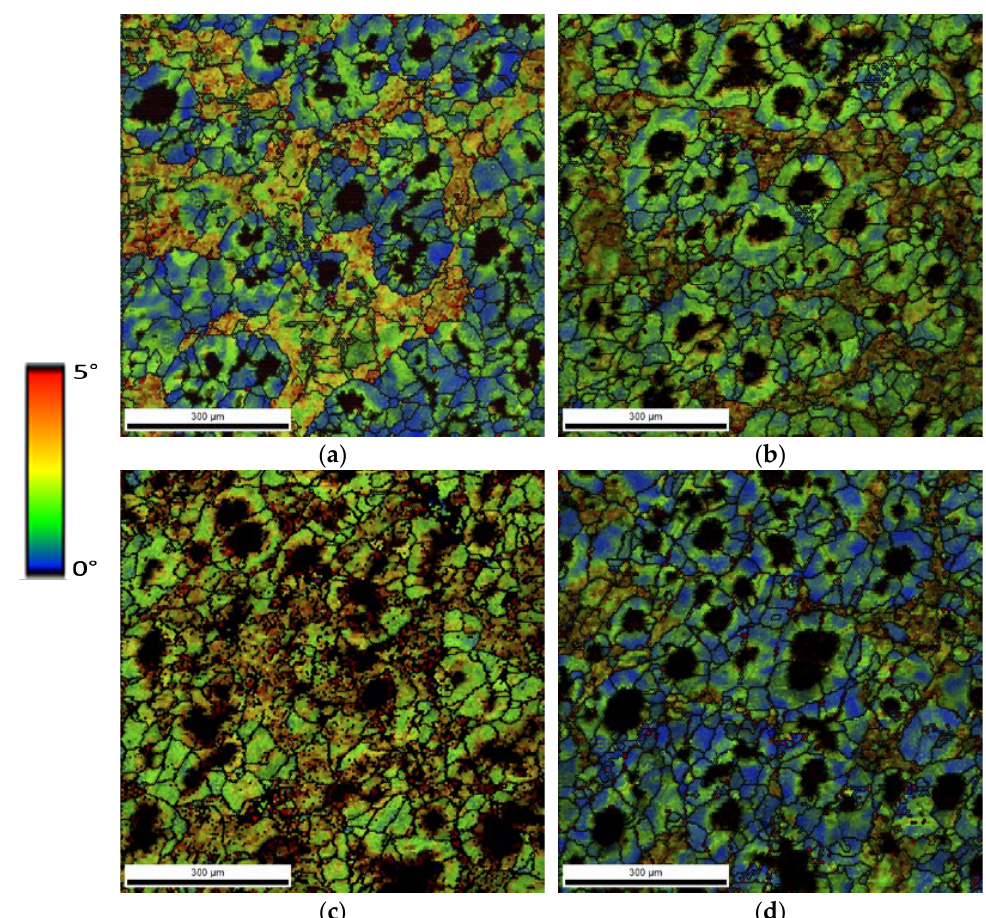
Figure 12. Kernel misorientation map (KAM) superimposed with image quality for each sample: ( a ) noP Un , ( b ) CP Un , ( c ) LCP Un , and ( d ) TP Un .